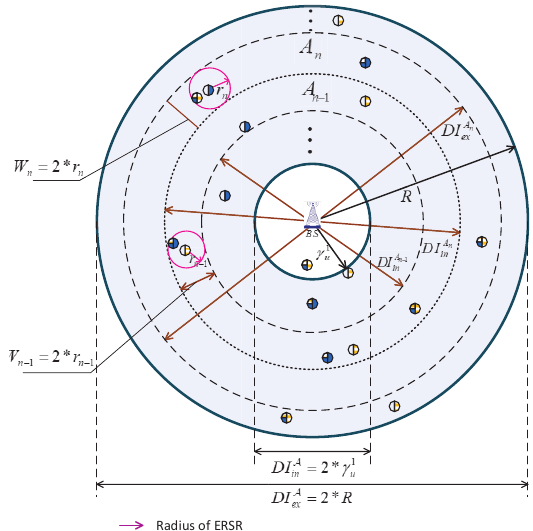
Figure 2. The model of range-division user relay